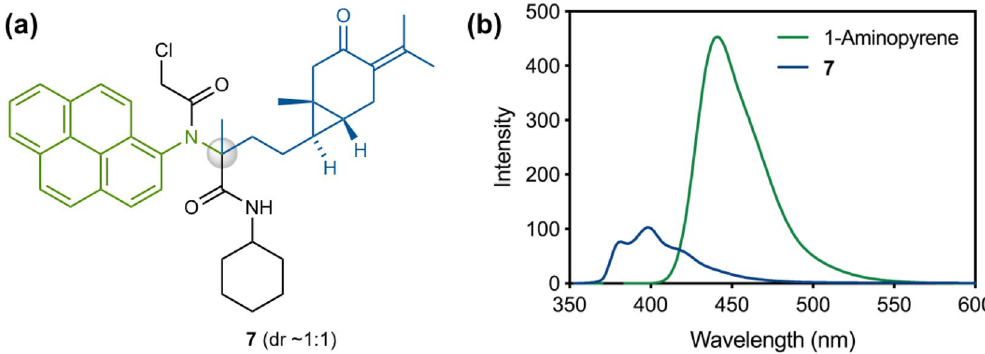
Figure 4. ( a ) Structure of 7 . ( b ) Fluorescence spectra of 1-aminopyrene and 7 (1 μM) in DMSO with 342 nm excitation.